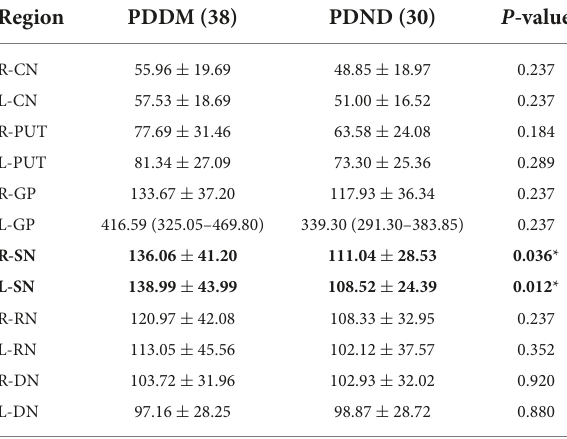
TABLE 3 MSV W of gray matter nucleus between PDDM group and PDND